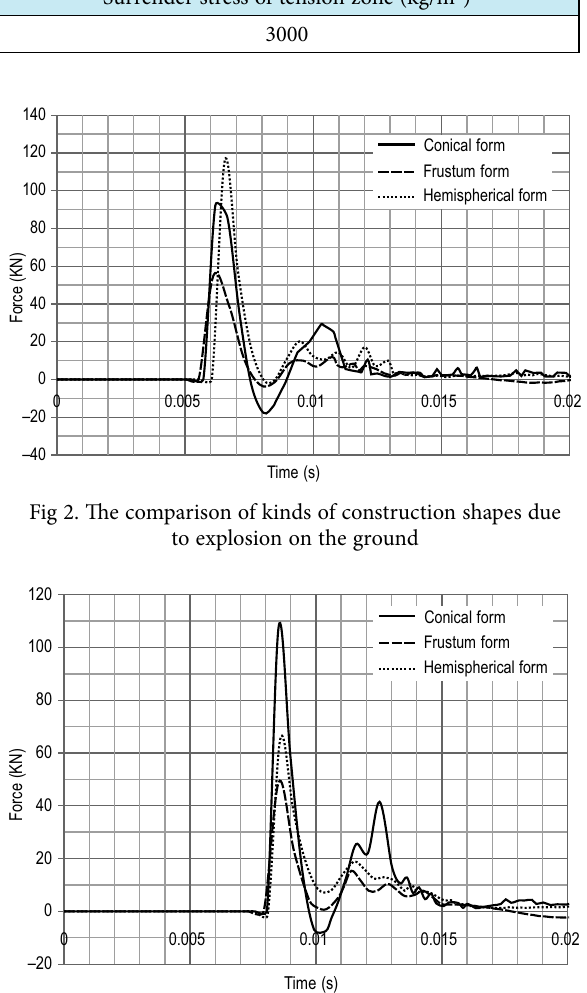
Fig. 3. The comparison of types of building shapes due to explosion in the middle of building